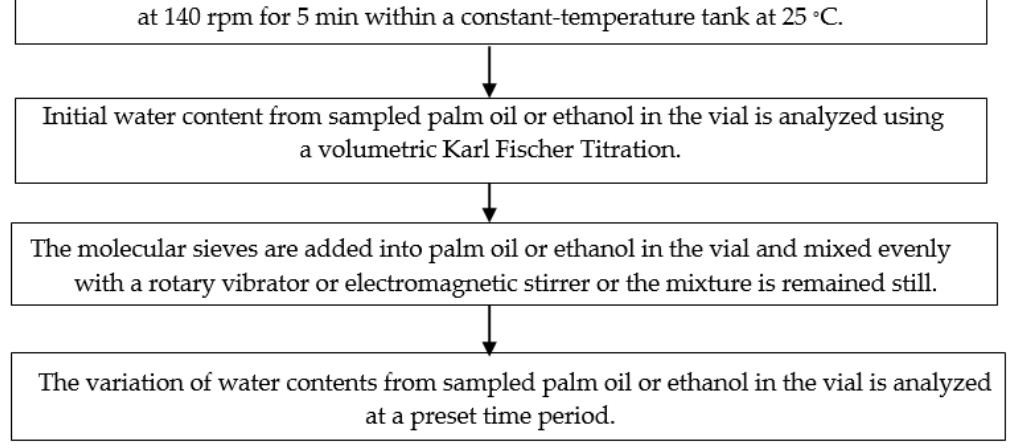
Figure 1. The experimental procedures for removing water from palm oil or ethanol by molecular sieves under different vibrating modes.